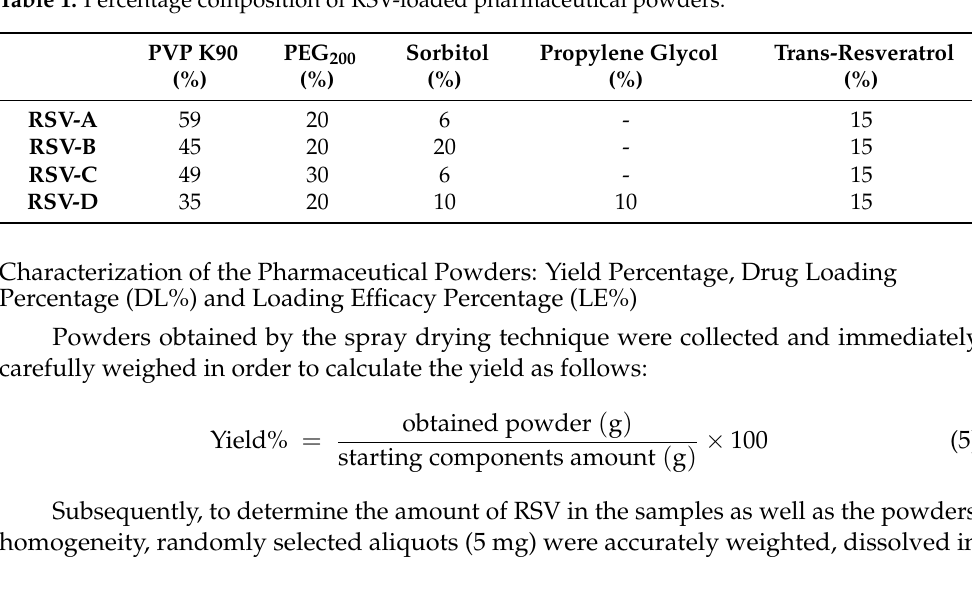
Table 1. Percentage composition of RSV-loaded pharmaceutical